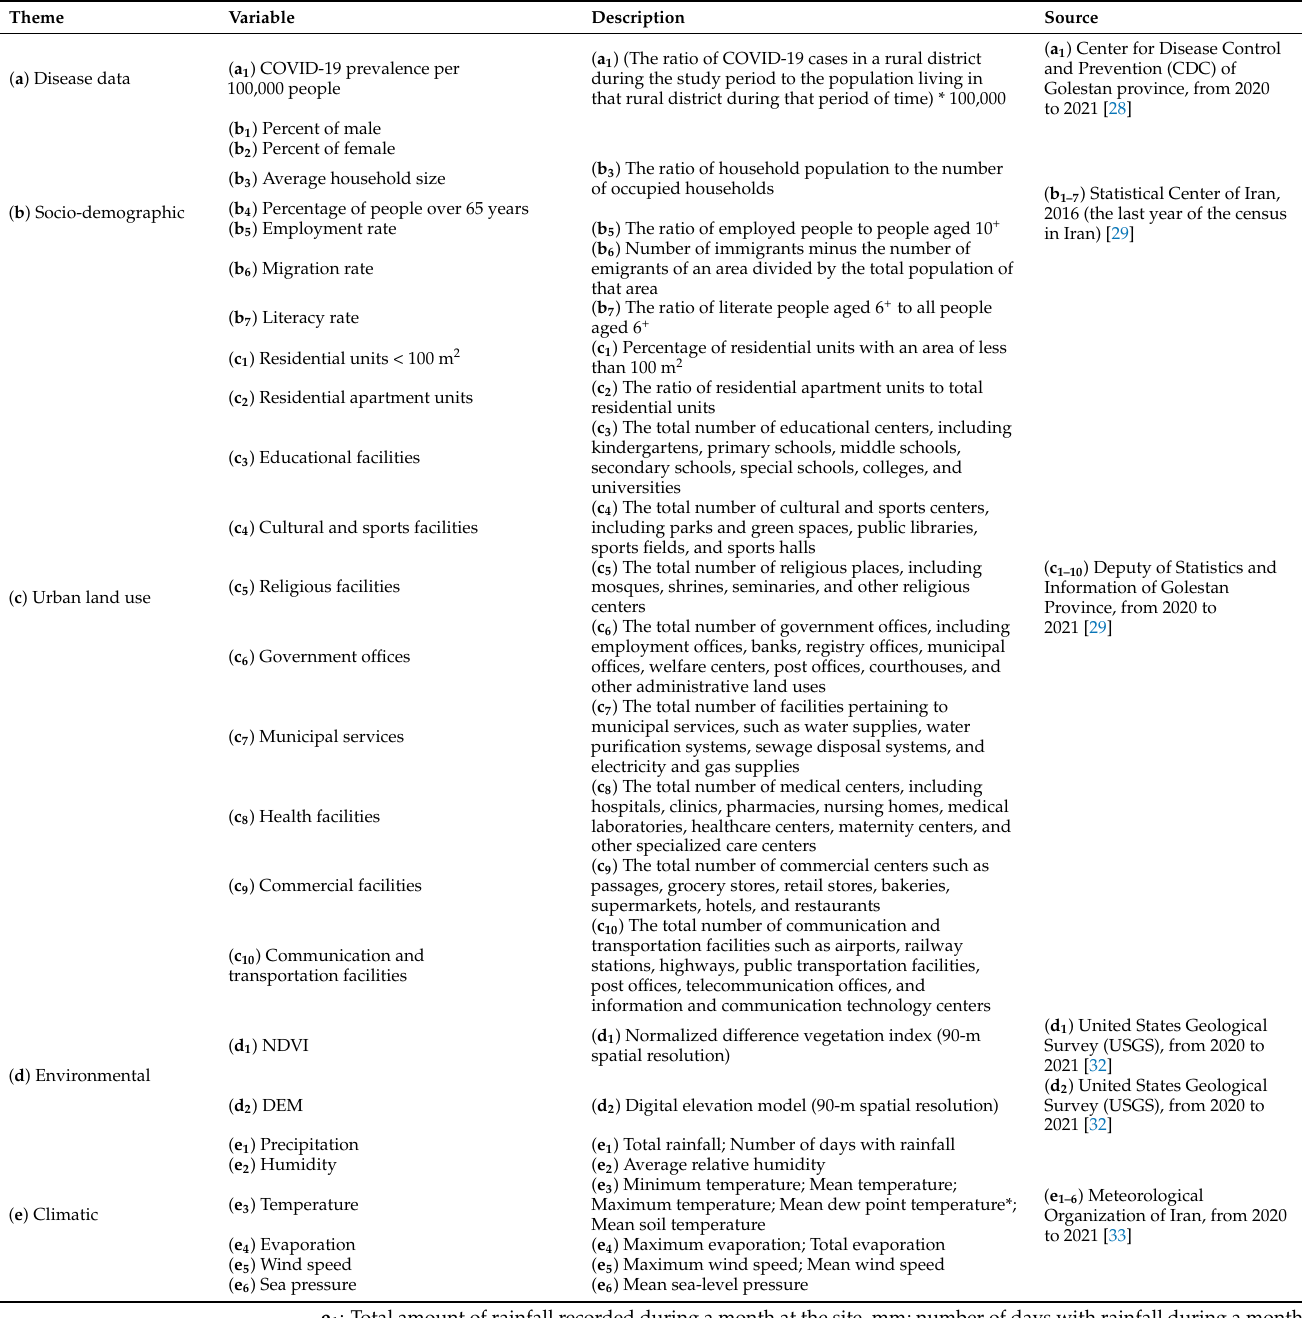
Table 1. Summary of the dataset used in this